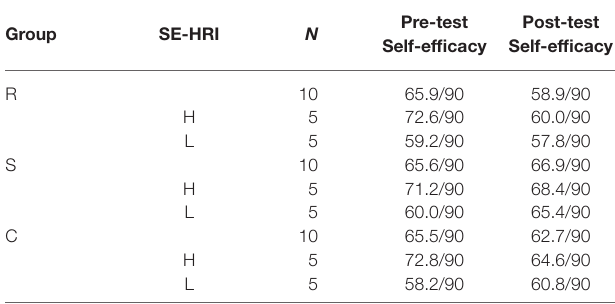
TABLE 3 | Changes in participants’ self-efficacy. Group SE-HRI N